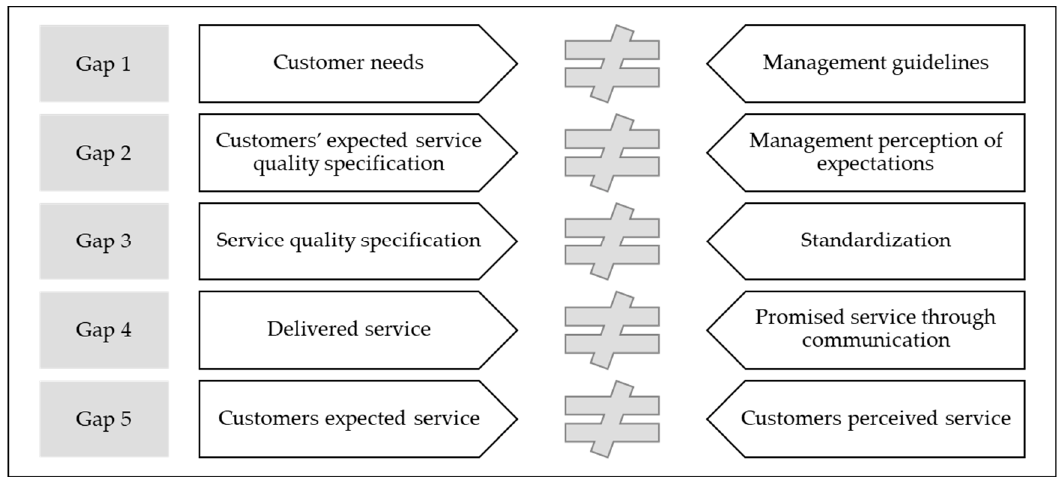
Figure 1. The five mismatches (gaps) between customers’ expected and perceived service quality.